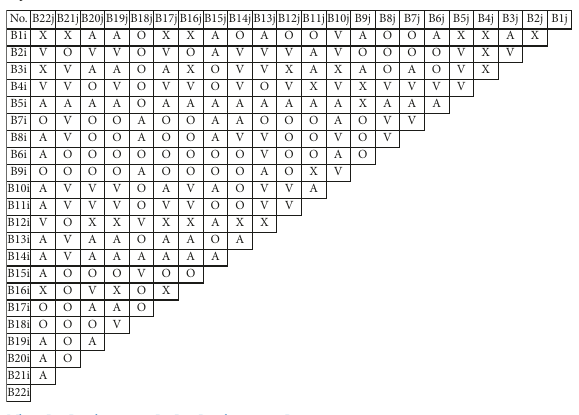
Where: B1i, B1j= barrier 1 or B1; B2i=B2j= barrier 2 or B2,